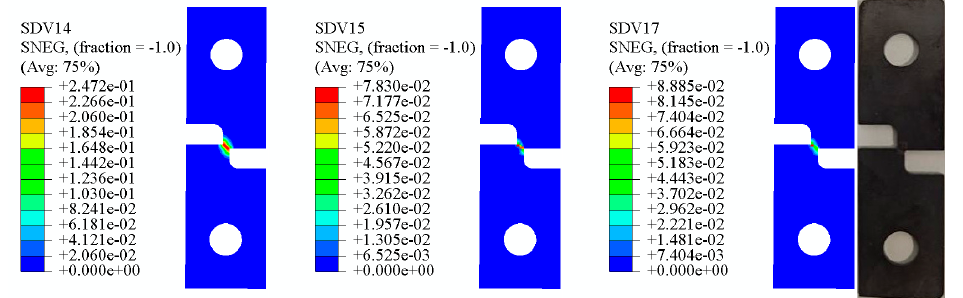
Figure 16. Equivalent plastic strain, VVF, shear damage at the beginning of microcrack in 60°speci- men and the result diagram of specimen.